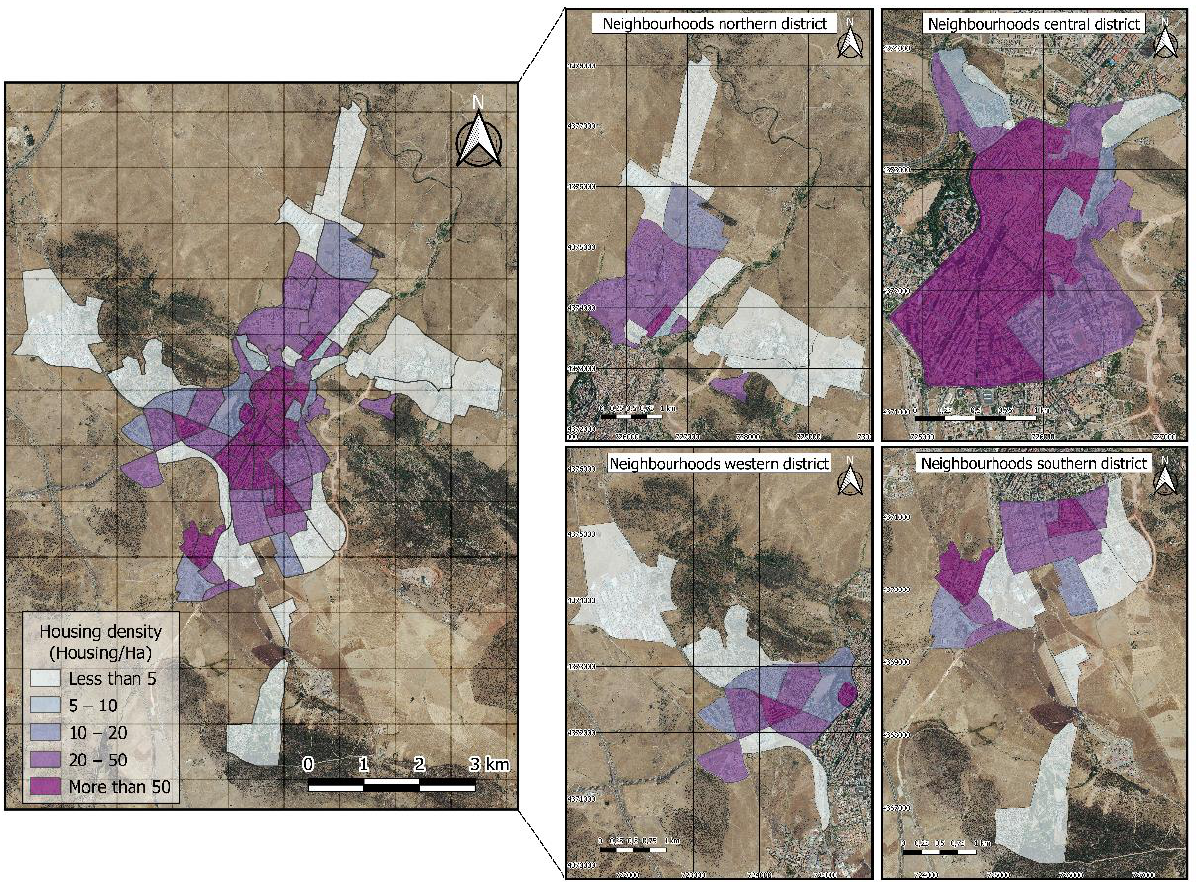
Figure 5. Housing density.